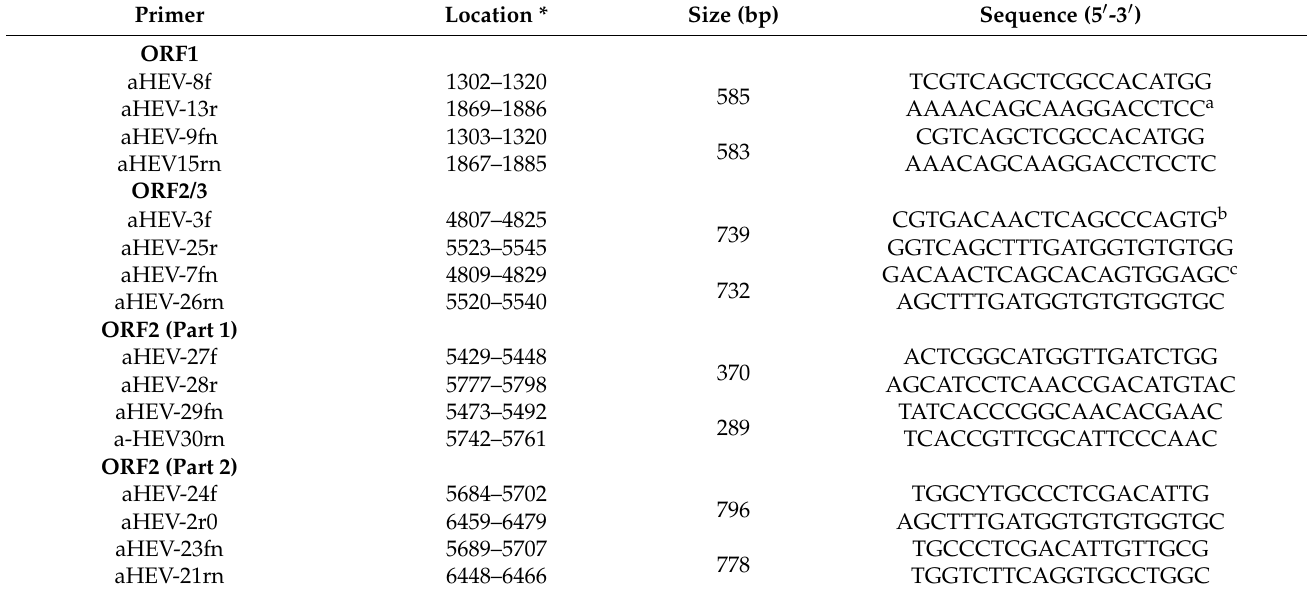
Table 1. Primers for the characterization of